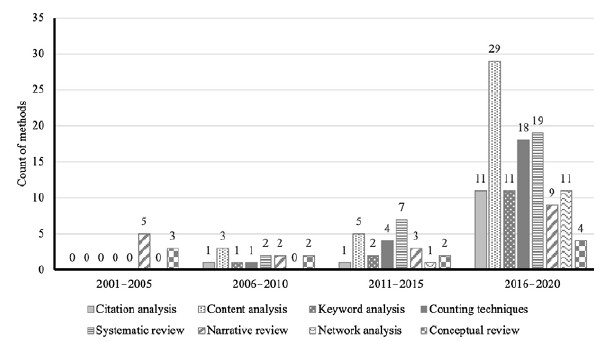
Figure 2. Distribution of methods used in the literature